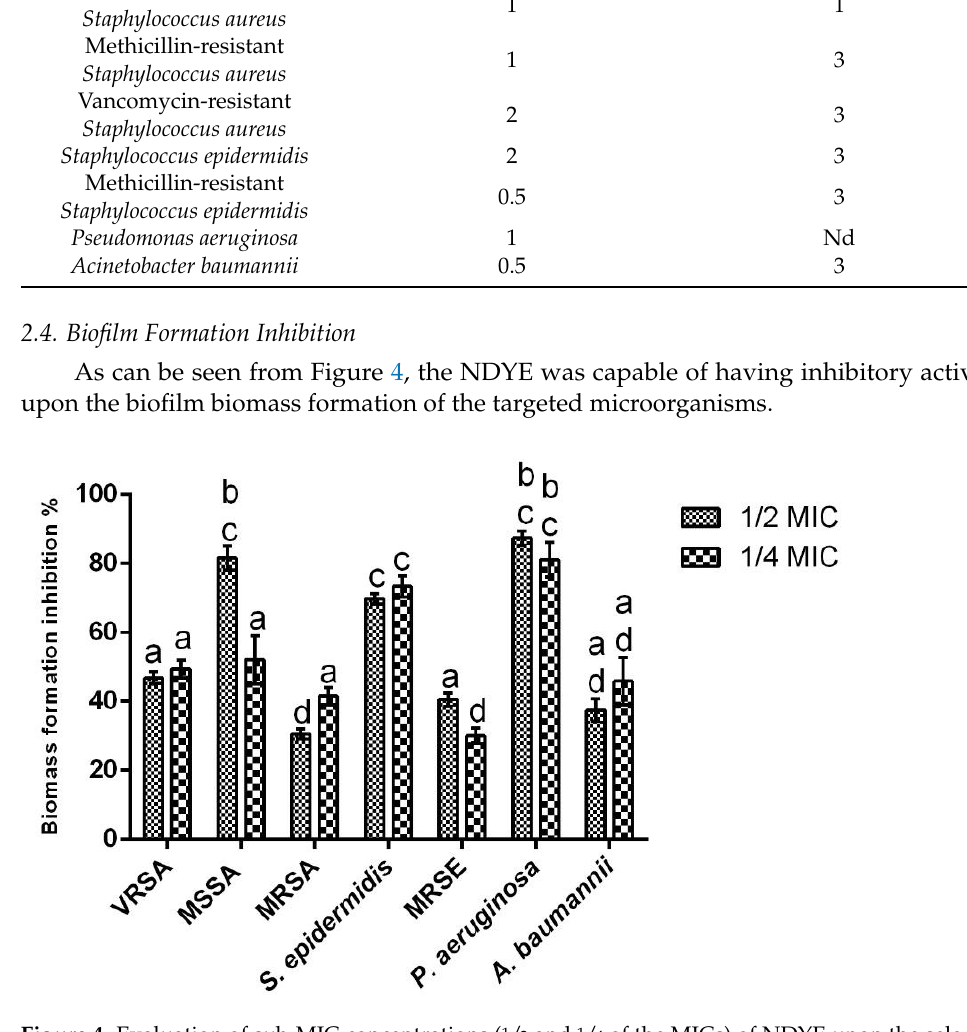
Figure 4. Evaluation of sub-MIC concentrations ( 1 / 2 and 1 / 4 of the MICs) of NDYE upon the selected microorganism’s biofilm formation. Values obtained are given in percentage of biofilm formation inhibition. Different letters represent statistically significant differences found ( p < 0.05).